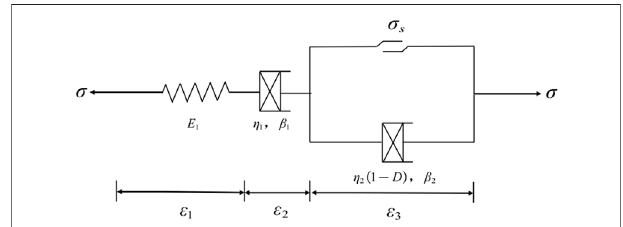
FIGURE 5 | Fractional-order damage creep